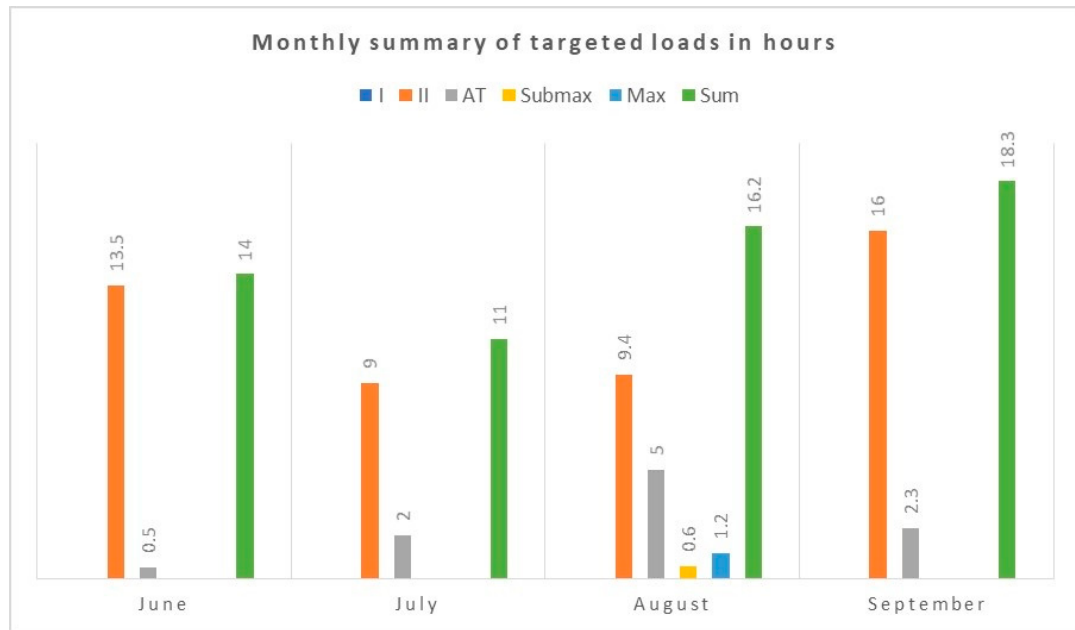
Figure 2. Monthly summary of targeted loads in hours.